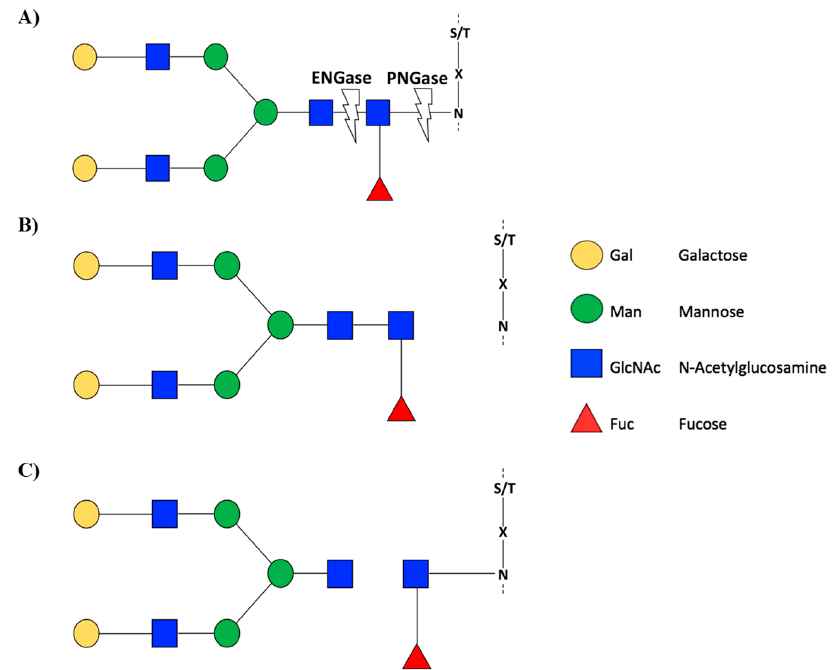
Figure 2. Schematic representation of the EnGase and PNGase enzyme activity. ( A ) PNGase F has activity in the glycosidic bond between asparagine amino acid and GlcNAc glycan, while, ENGase has activity in the glycosidic bond between two GlcNAc glycans. As result, with PNGase F glycosylation is completely cleaved (showed in B ). ENGase leaves a GlcNAc attached to the asparagine amino acid (showed in C ). Glycans are represented according to Consortium for Functional Glycomics (CFG). Recovered with modifications of Karav et al. [38] and Fairbanks [39].